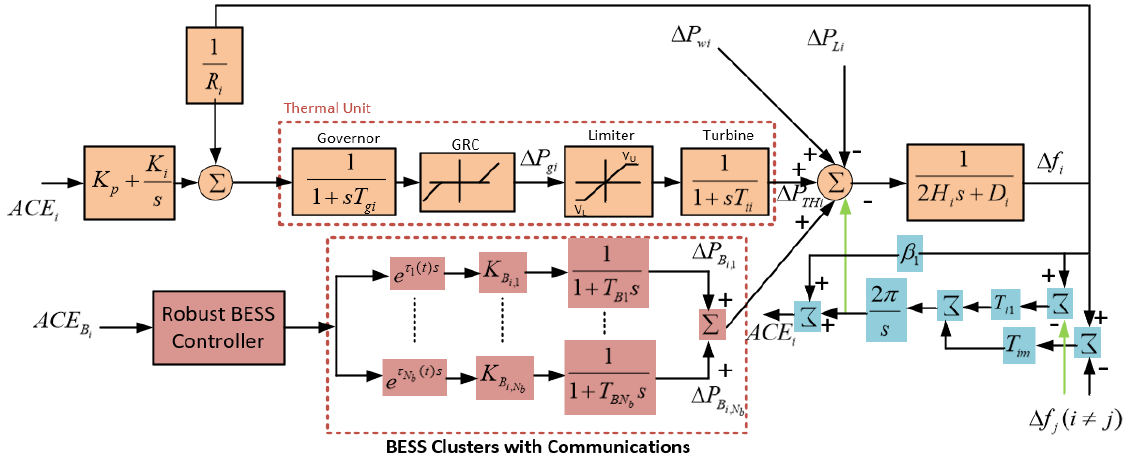
Figure 6. Dynamic control model of distributed